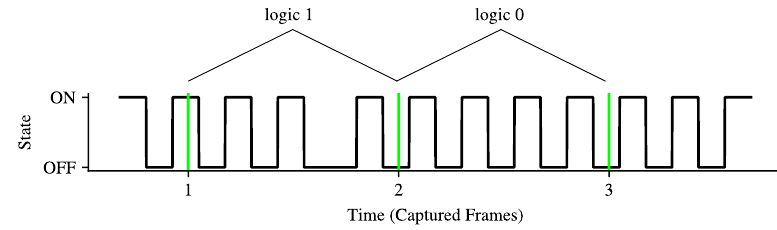
Figure 6. Original UDPSOOK modulation signal, based on [3].